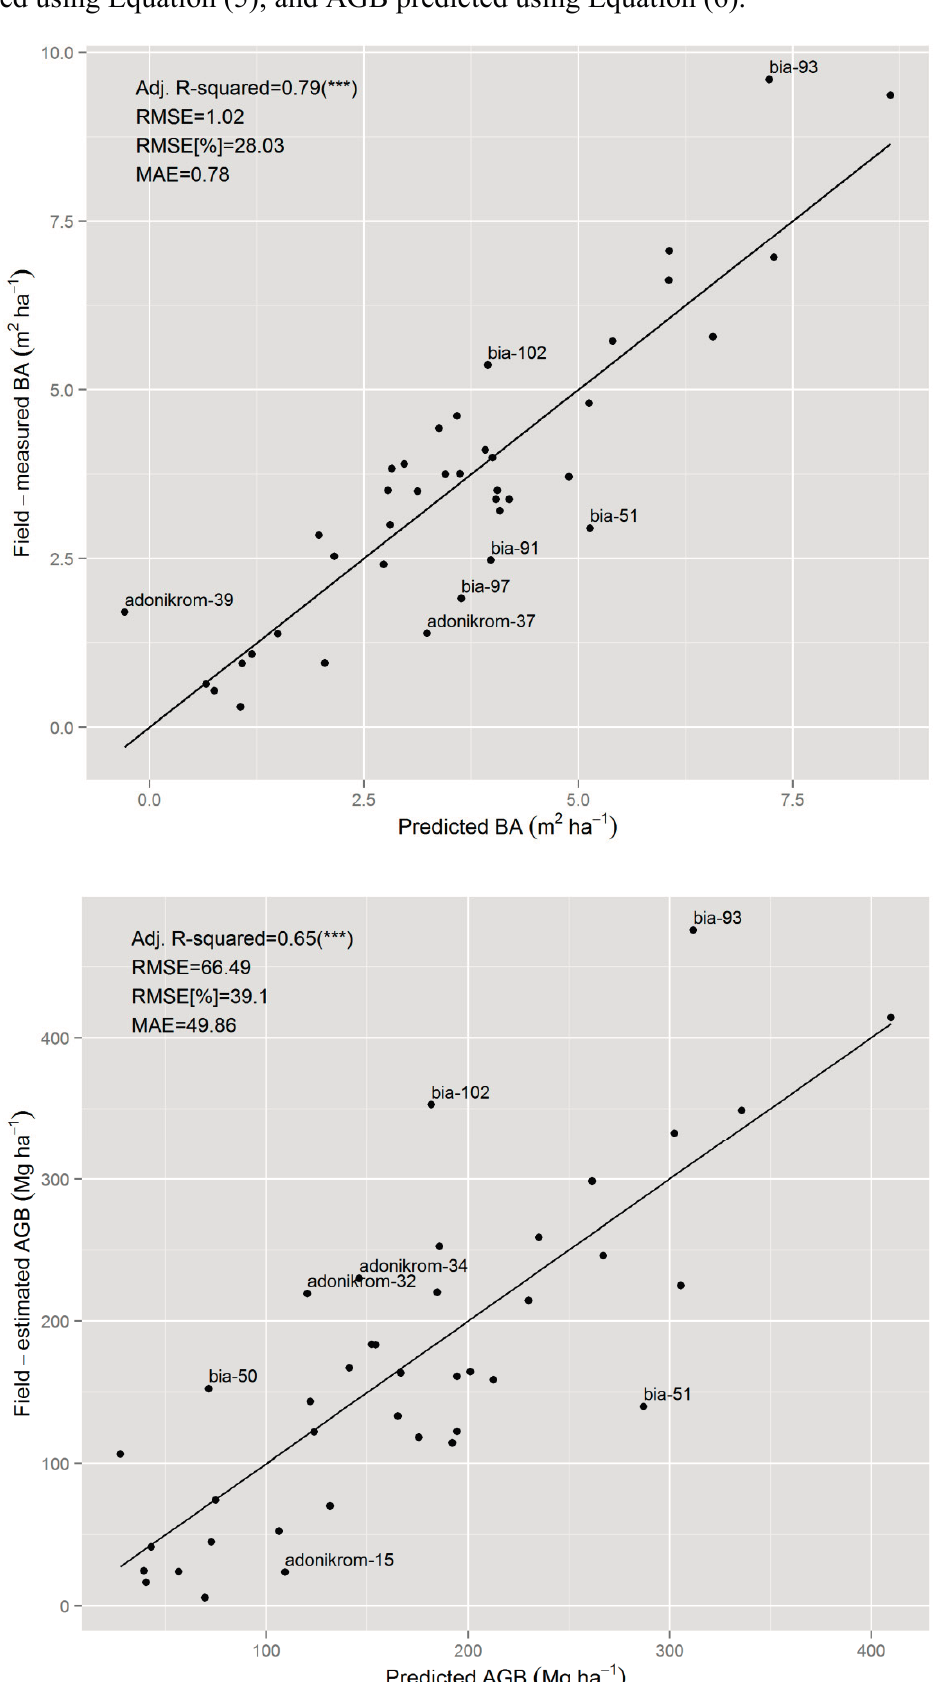
Figure 7. Predicted vs. reference values for BA and AGB from stepwise regression: BA predicted using Equation (5); and AGB predicted using Equation